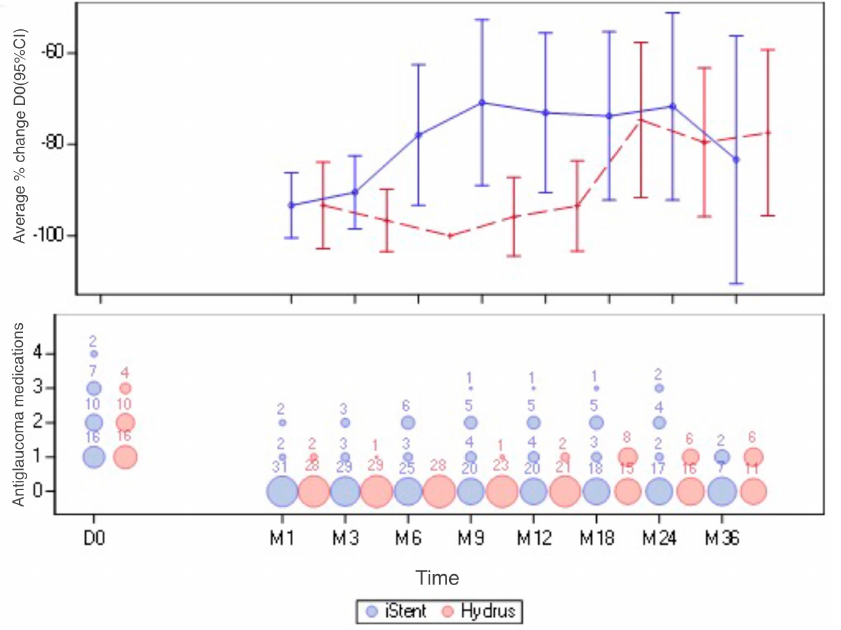
Figure 3. Mean percentage changes with 95% confidence intervals for iStent and Hydrus and the bubble chart with the number of antiglaucoma medications at each time